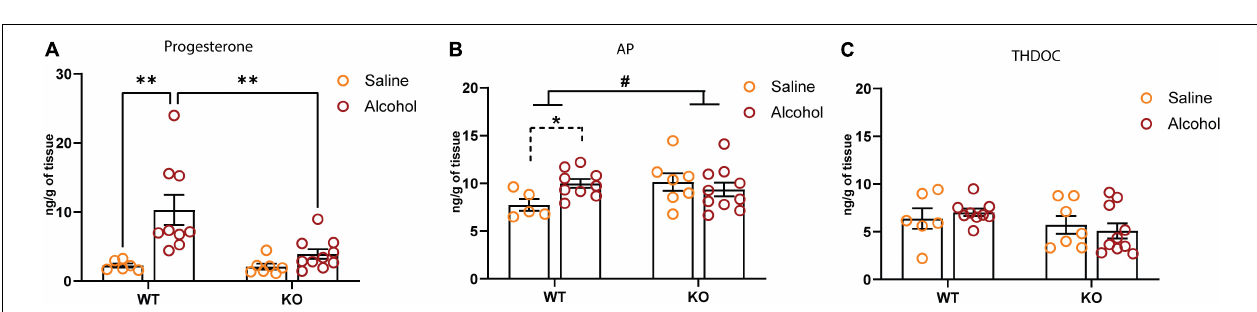
FIGURE 6 | Effect of systemic alcohol administration on brain level of progesterone, 3 α ,5 α -TH-PROG (allopregnanolone, AP), and 3 α ,5 α -tetrahydrodeoxy corticosterone (THDOC). (A) Levels of progesterone in the hippocampus of WT and KO mice 60 min after systemic alcohol or saline administration. Post hoc test ( ∗∗ p < 0.01) (WT saline, n = 5; KO saline, n = 6; WT alcohol, n = 9; KO alcohol, n = 10). (B) Levels of AP in the hippocampus of WT and KO mice 60 min after systemic alcohol or saline administration. Genotype × treatment interaction is indicated with solid lines (# p < 0.05); unpaired t -test is indicated with dashed lines ( ∗ p < 0.05) (WT saline, n = 5; KO saline, n = 7; WT alcohol, n = 9; KO alcohol, n = 10). (C) Levels of THDOC in the hippocampus of WT and KO mice 60 min after systemic alcohol or saline administration (WT saline, n = 6; KO saline, n = 7; WT alcohol, n = 9; KO alcohol, n = 10). All data are expressed as mean ±